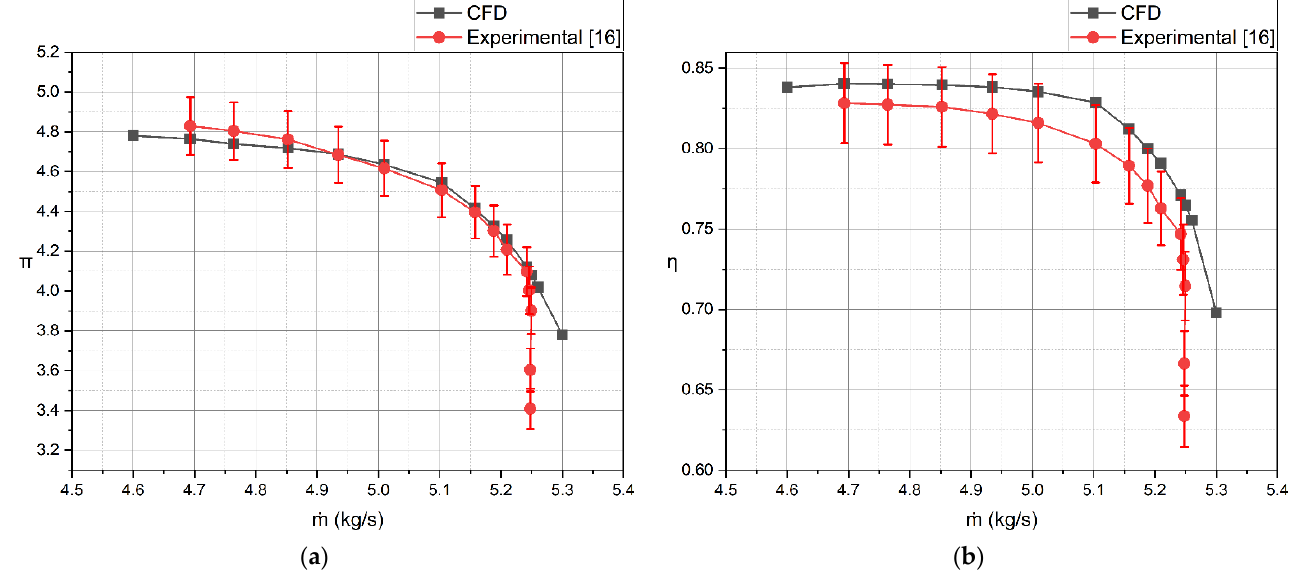
Figure 4. Comparison of CFD and experimental results (CFD results are within an error band of ±3%): ( a ) pressure ratio, π; ( b ) adiabatic efficiency, η.